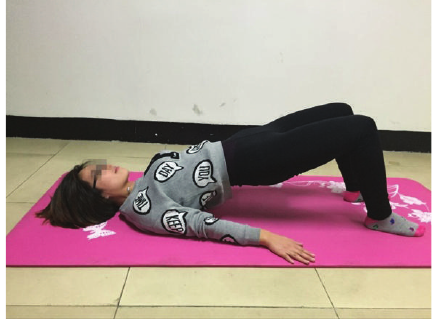
Figure 3: Unilateral